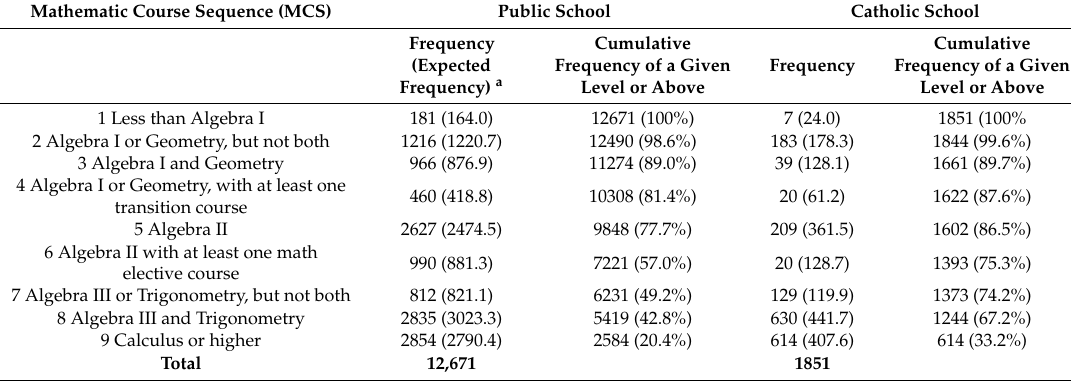
Table 6. Baseline di ff erence in mathematic course sequence (MCS) between di ff erent school sectors and Chi square test ( n = 14,522).